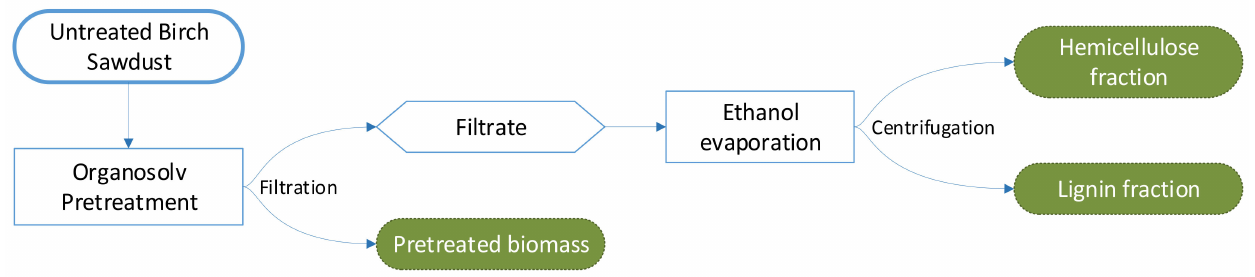
Figure 2. Diagram of the pretreatment process and obtained